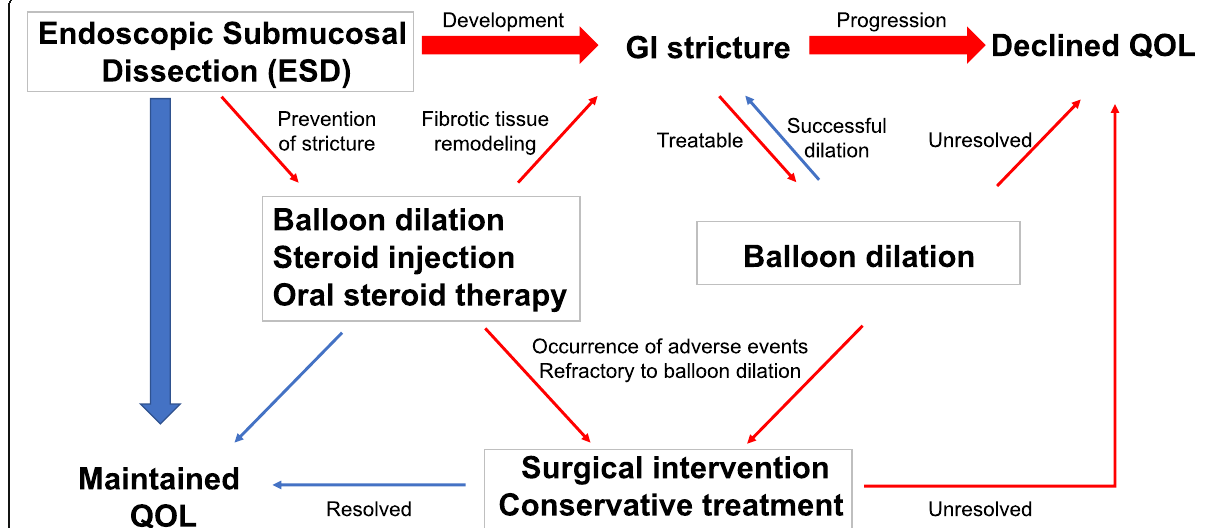
Fig. 1 Management of fibrostenosis after ESD. Prophylactic balloon dilatation, localized steroid injection therapy, and oral steroid therapy are administered to prevent fibrostenosis after ESD. If a GI stricture develops, balloon dilation or surgical treatment is considered. Multiple types of treatment lead to diminution of a patient ’ s